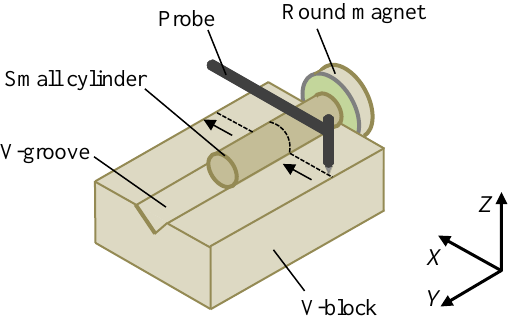
Figure 2. A schematic of the stitching linear-scan method.